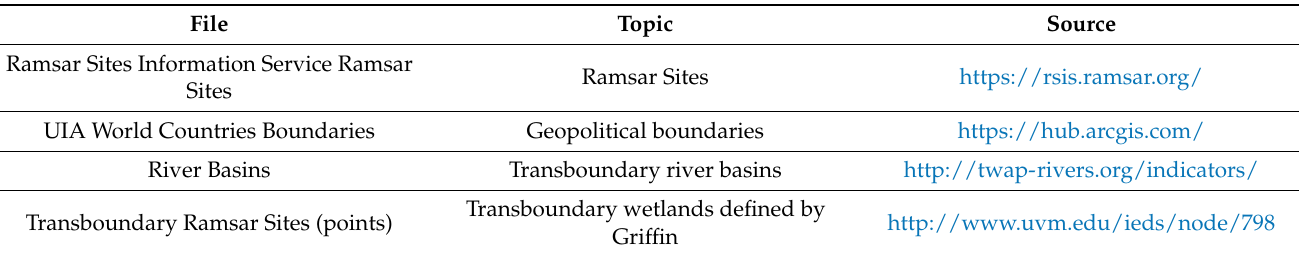
Table 2. Map layers included in the spatial analysis. All sources were accessed on 9 July